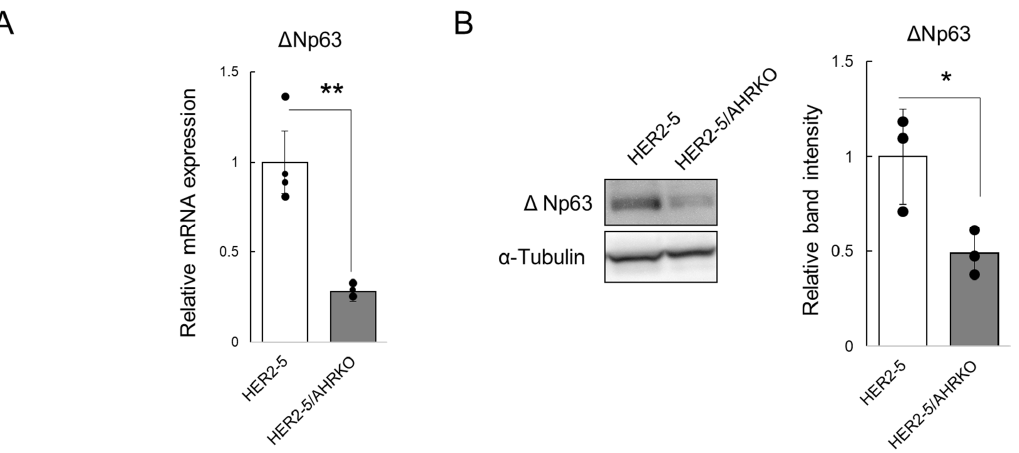
Figure 2. Downregulation of ΔNp63 mRNA and protein levels in HER2-5/AHRKO cells. ( A ) ΔNp63 mRNA levels were measured by RT-qPCR analysis. ΔNp63 mRNA levels were normalized to those of B2M . Values are expressed as relative values (those in HER2-5 cells were set at 1) and the mean ± S.D. (n = 4). **, p < 0.01 (Student’s t test). Each dot represents individual data points of quadruplicate measurements. The depicted results are representative of two independent biological experiments. ( B ) Whole-cell lysates (10 µg) were resolved by sodium dodecyl sulfate-polyacrylamide gel electro- phoresis, and proteins were detected by immunoblot analysis using antibodies against ΔNp63 and α-tubulin. The intensity of ΔNp63 and α-tubulin protein bands was measured using ImageJ soft- ware. ΔNp63 levels were normalized to those of α-tubulin and are expressed as relative values (those in HER2-5 cells were set at 1) based on the mean ± S.D. (n = 3). Each dot represents independ- ent biological data points of triplicate measurements. *, p < 0.05 (Student’s t test).